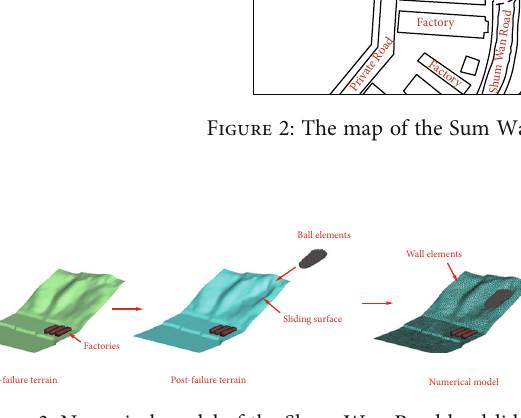
Figure 3: Numerical model of the Shum Wan Road